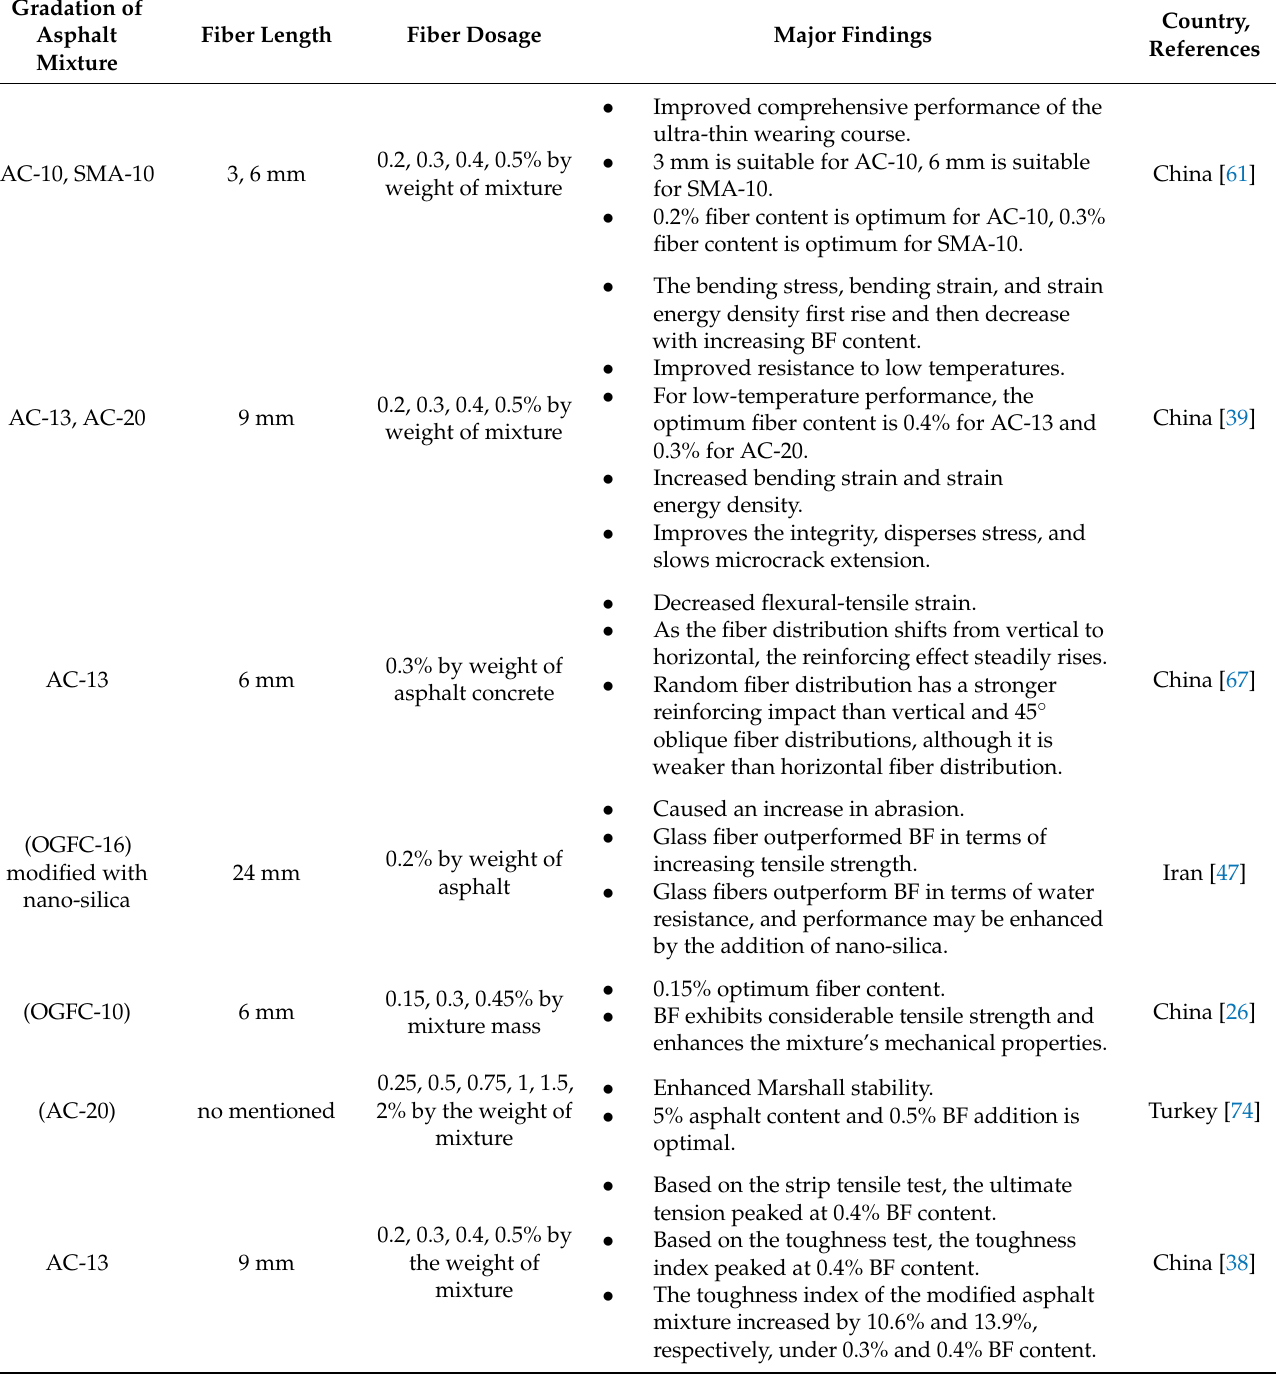
Table 3. A summary of research on basalt fiber for